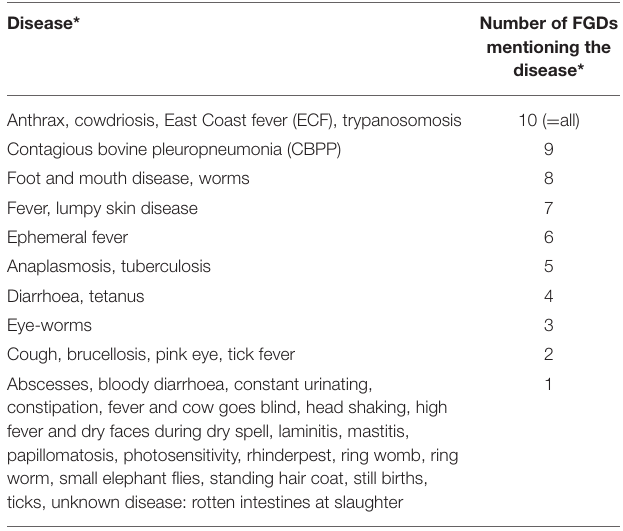
TABLE 1 | Exhaustive list of all cattle diseases, syndromes, signs or external parasites mentioned in focus group discussions (FGDs). Disease* Number of FGDs